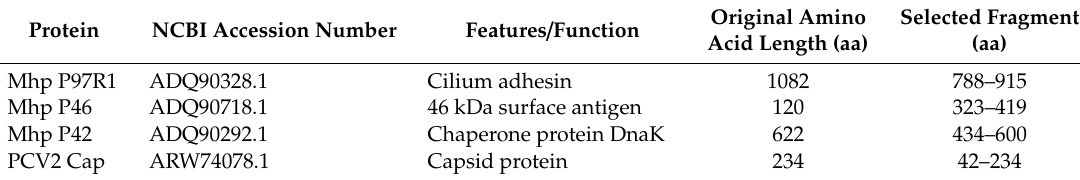
Table 1. Antigens selected in this